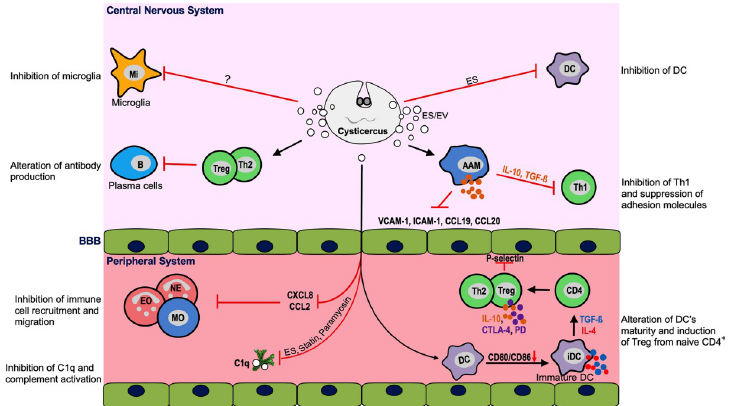
Fig 3. Host immune regulation during parenchymal NCC. Viable cyst releases ES products and EVs that interact with resident brain cells (microglia and DCs) and induce AAMs, which suppress adhesion molecules and local Th1 response via TGF-ß and IL-10. Excreted products reach peripheral system where they drive the expansion of suppressive Tregs from CD4 + cells through the alteration of the maturation of DCs. Furthermore, cyst products inhibit complement C1q activity and prevent the infiltration and migration of neutrophils, eosinophils and MO from the peripheral system into the brain via production of immunomodulatory cytokines and blocking of chemokines and adhesion molecules. AAM, alternatively activated macrophages; B, ; BBB, blood–brain barrier; CCL, chemokine C-C ligand; CD4, cluster of differentiation 4; C1q, complement first component; CTLA-4, cytotoxic T-lymphocyte associated protein 4; CXCL, chemokine C-X-C ligand; DC, dendritic cell; EO, eosinophil; ES, excretory–secretory; EV, extracellular vesicle; ICAM-1, intercellular adhesion molecule 1; iDC, immature DC; IL, interleukin; Mi, microglia; MO, monocytes; NCC, neurocysticercosis; TGF-ß, transforming growth factor beta; Th, T helper; Treg, regulatory T cell; VCAM-1, vascular cell adhesion protein 1.